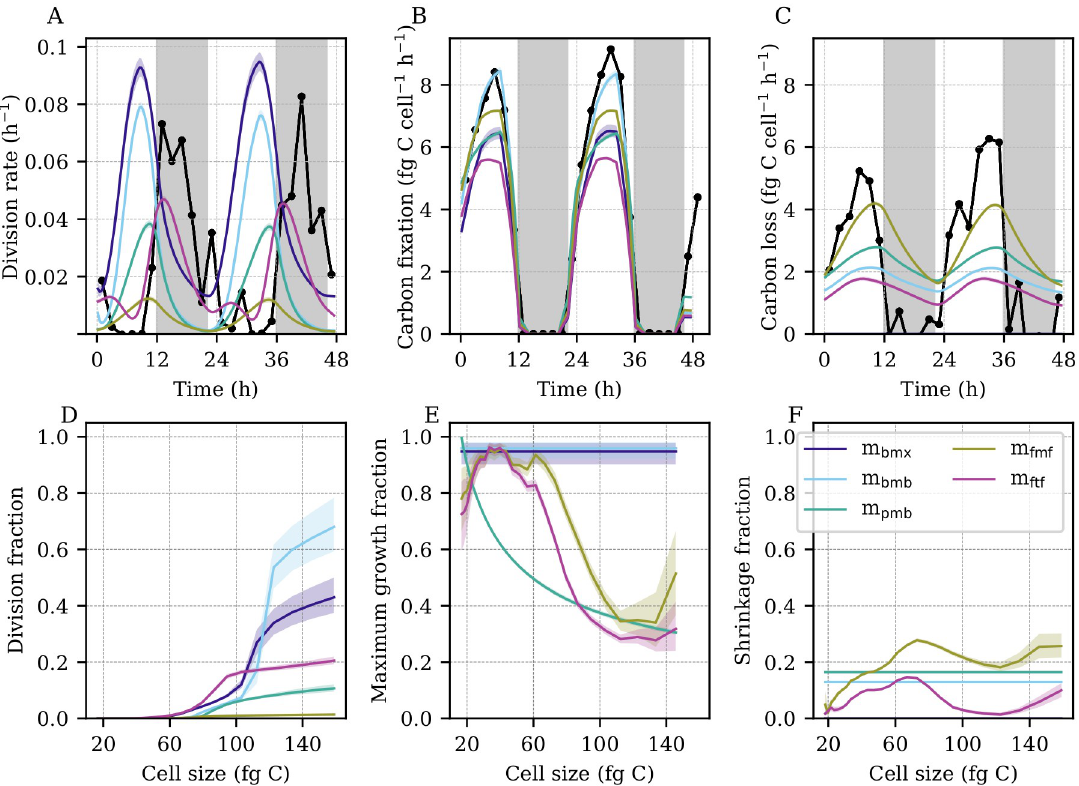
Fig 5. Model estimated hourly rate parameters. (A) Observed (black) and estimated (colored bands) hourly division rates. (B) Observed (black) and estimated (colored bands) hourly carbon fixation. (C) Observed (black) and estimated (colored bands) hourly carbon loss. (A-C) Black points indicate ground truth calculated from data. (D) Estimated cell division fraction as a function of cell size. (E) Estimated light-saturated cell growth (carbon fixation) fraction as a function of cell size. (F) Estimated cell shrinkage (carbon loss) fraction as a function of cell size. (A-F) Colored bands indicate model estimates. Shading indicates the first to third quartiles of the posterior distributions. (D-F) Fractions correspond to MPM transitions over a 20-minute time